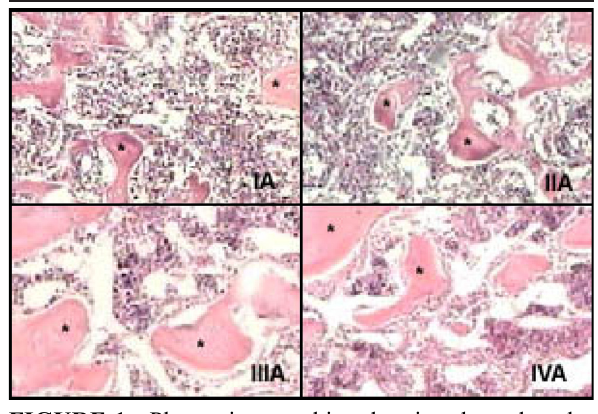
FIGURE 1 - Photomicrographies showing the trabecular formation (*) in the defect areas under light microscopy. Follow-up 7 days. HE-100X